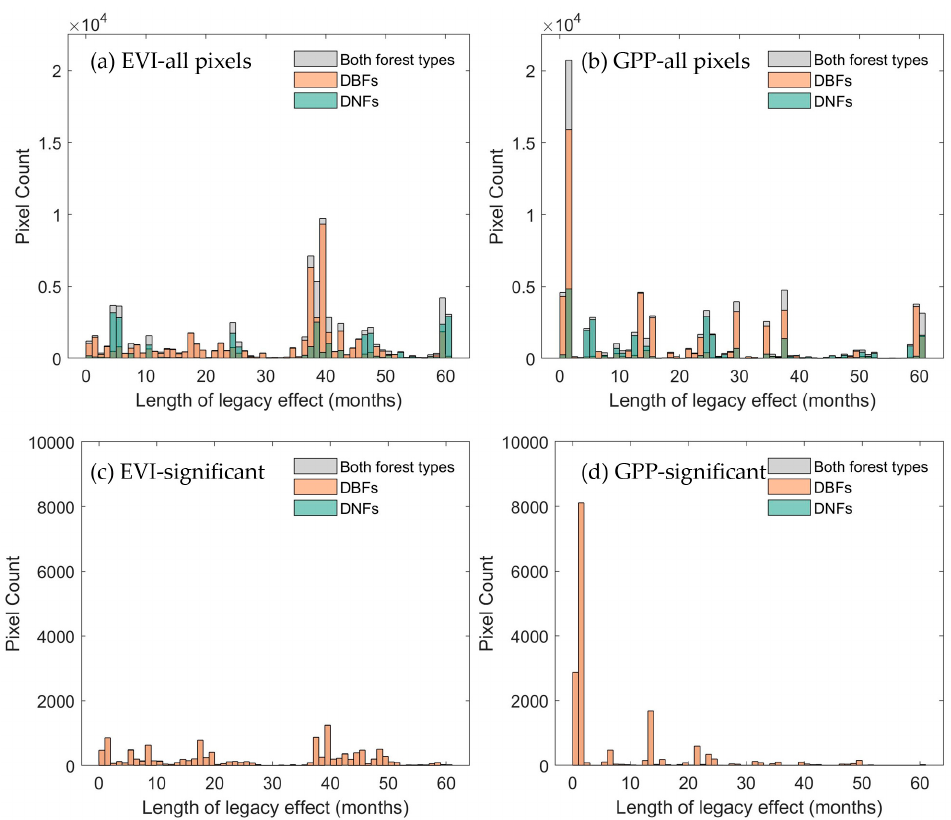
Figure 6. The histograms of the legacy length of the SPEI on ( a ) the growing season EVI of all constant pixels, ( b ) the growing season GPP of all constant pixels, ( c ) the growing season EVI for significantly correlated pixels only ( p < 0.05), and ( d ) the growing season GPP for significantly correlated pixels only ( p < 0.05) during 2001–2018.